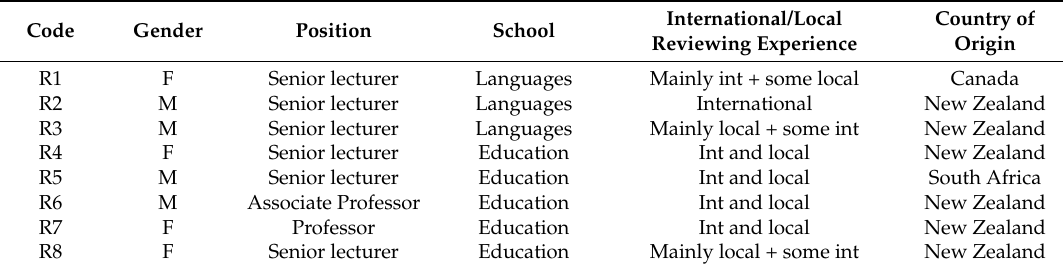
Table 1. ( n = 8) Participant